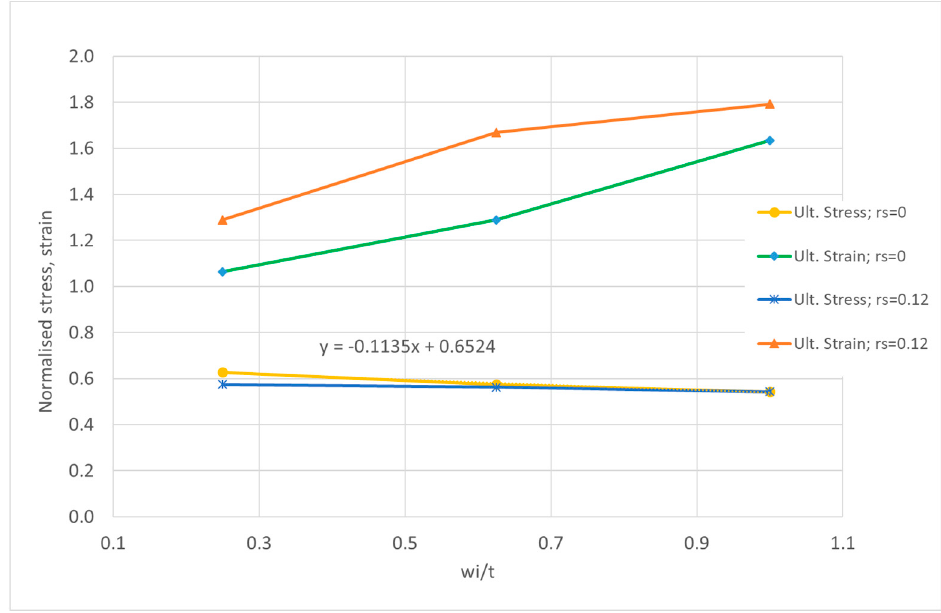
Figure 13. Variation of ultimate strength and corresponding normalized strain for plates with t = 8 mm, m = 3 and residual stresses with η = 0, 4.